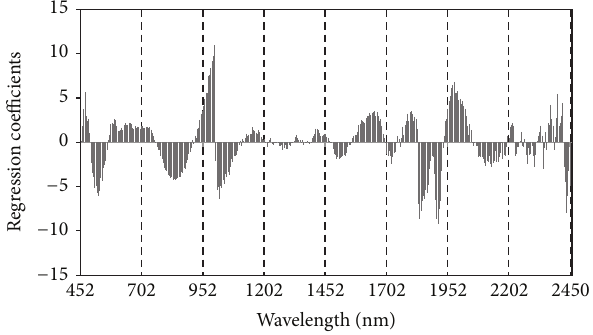
Figure 4: Plot of regression coefficients versus wavelength derived from partial least-squares (PLS) regression analysis for 10 latent variables withrawreflectance spectraof 114diesel-contaminated soil